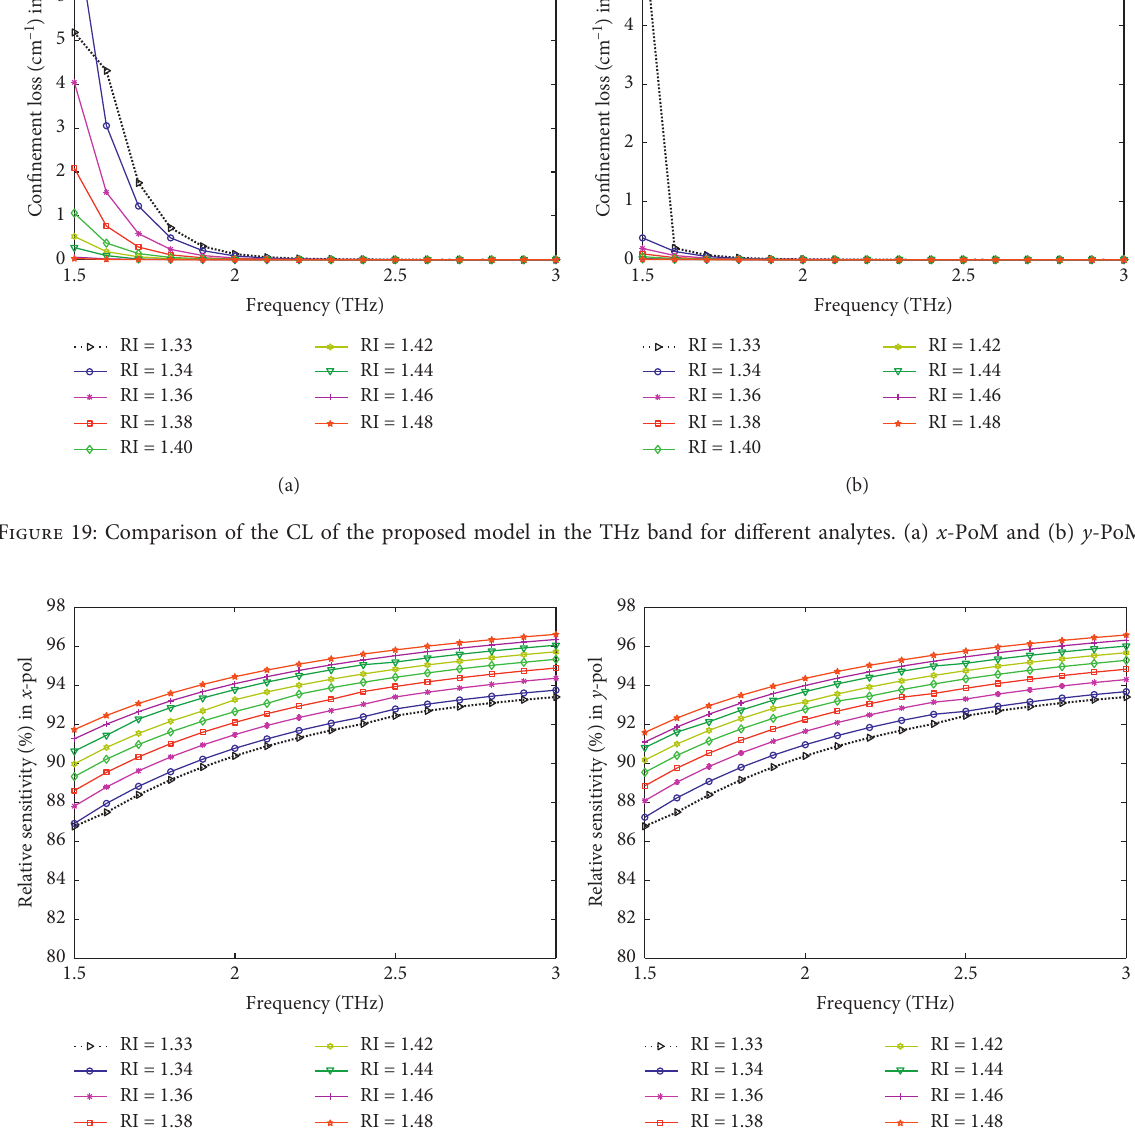
RI = 1.33 RI = 1.34